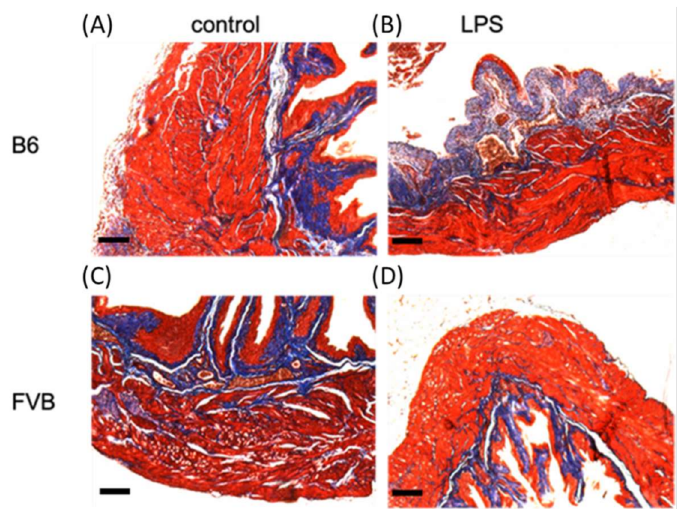
Figure 5. Bladder histology of ( A ) B6-ctrl, ( B ) B6-LPS mice, ( C ) FVB-ctrl and ( D ) FVB-LPS. The